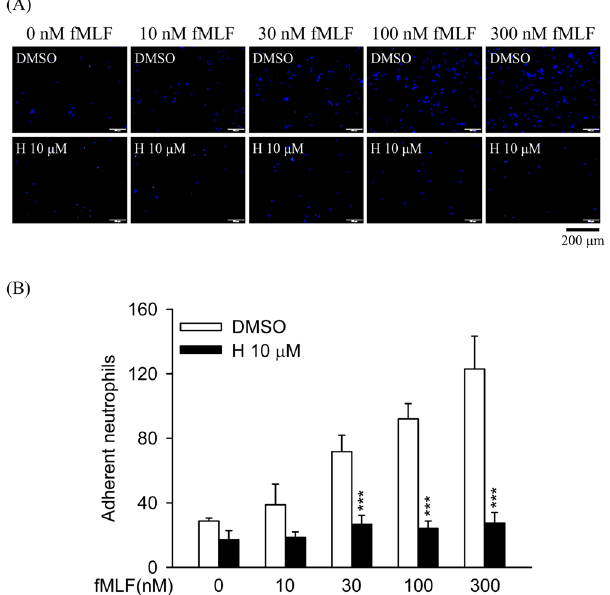
Figure 8. Honokiol inhibits fMLF-induced adhesion of human neutrophils to endothelial cells (ECs). Hoechst-labelled neutrophils were incubated with 0.1% DMSO (as control) or honokiol (H; 10 μ M) for 5 min before activation with different concentrations of fMLF and priming with CB. Activated neutrophils were then co-cultured with LPS-pre-activated ECs for 15 min. ( A ) Adherent neutrophils on ECs were detected using microscopy. Bar (bottom), 200 μ m. ( B ) Adherent neutrophils were measured and are shown as the mean ± S.E.M. ( n = 6). ** P < 0.01 compared with